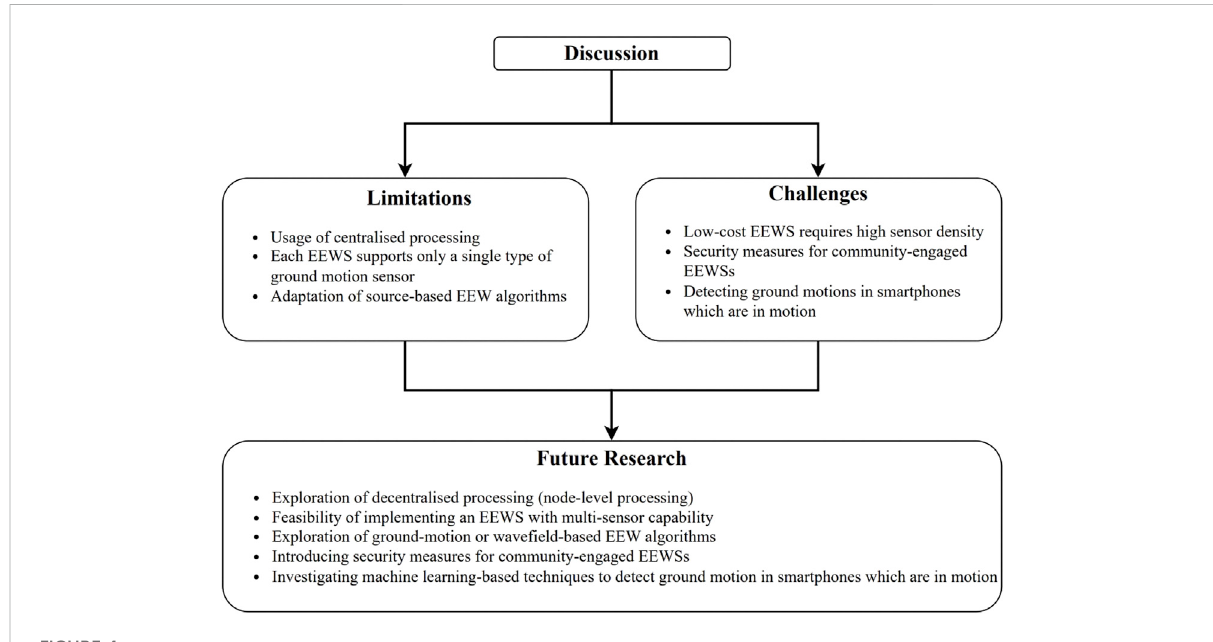
FIGURE 4 Discussion fl owchart that summarises the limitations, challenges, and future research identi fi ed during this